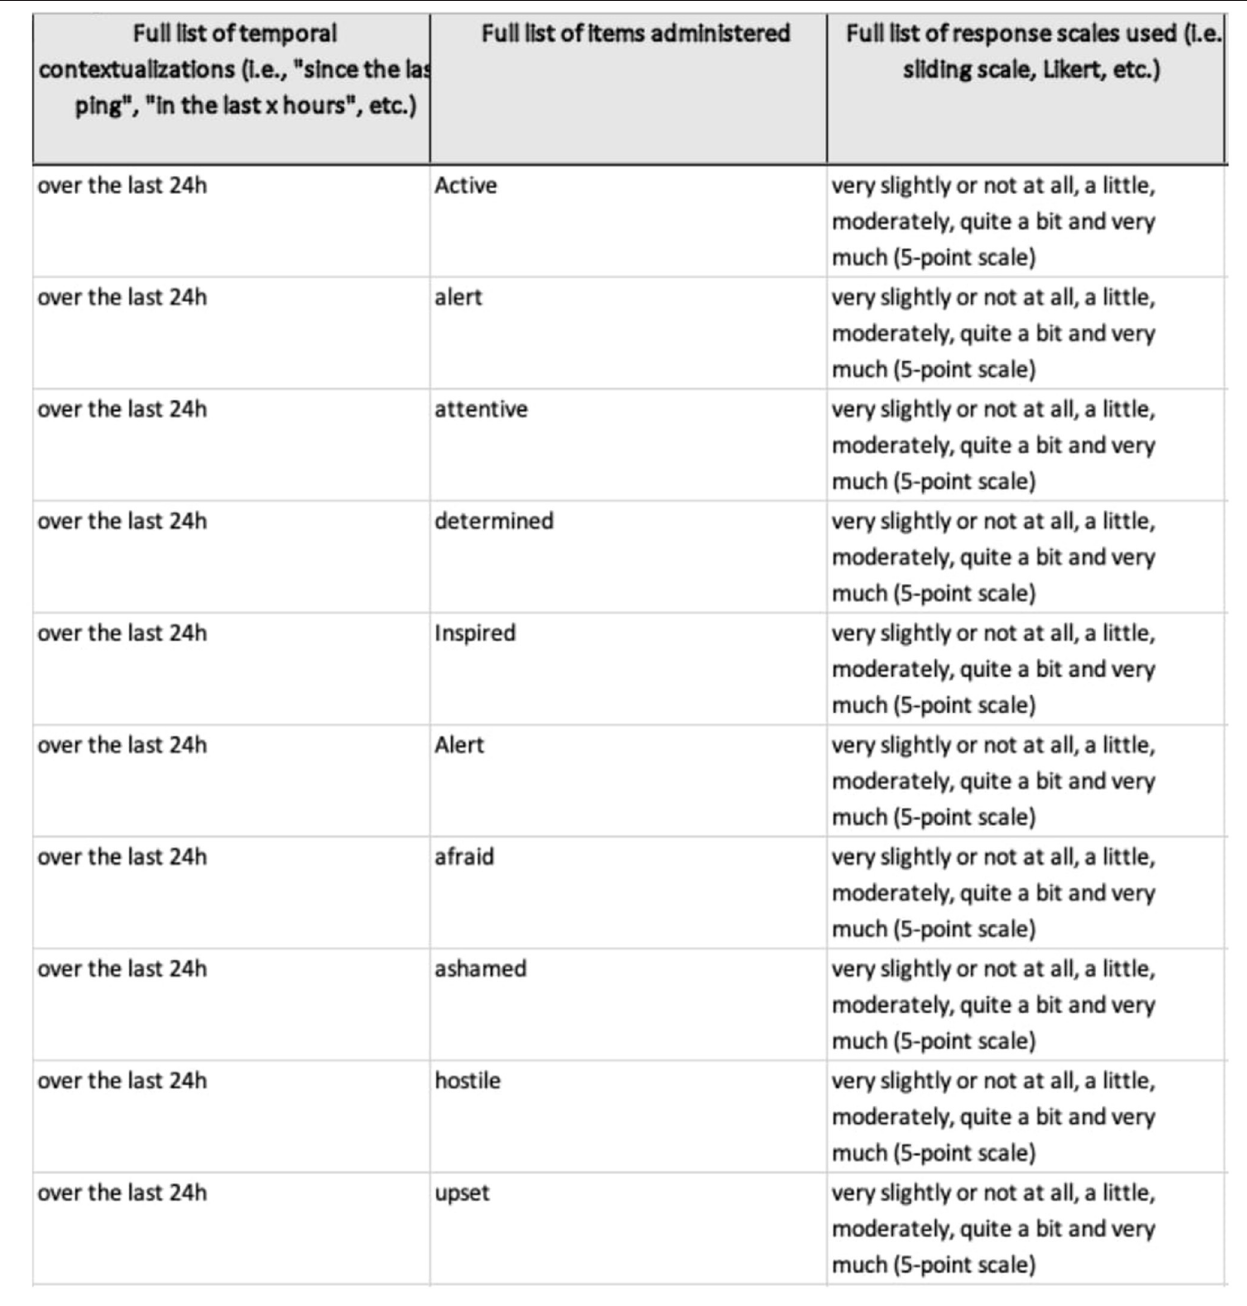
FIGURE 3 | Insight into full data extraction database. Screenshot of part of the database, available at https://osf.io/m8jsf/. The full file includes all the information described within the section Methods. Inconsistencies in formatting or phrasing are the result of differing amounts of detail from paper-to-paper, different people having conducted the data extraction, or as a code for how the data was attained (yellow boxes indicate that the information was missing in the original paper, but were found in a different source, italics and square brackets indicate vague phrasing). Full details, including the instructions provided during data extraction, can be found in the Rater Guides on the aforementioned OSF page. The corresponding author will gladly update or add information from authors cited, if